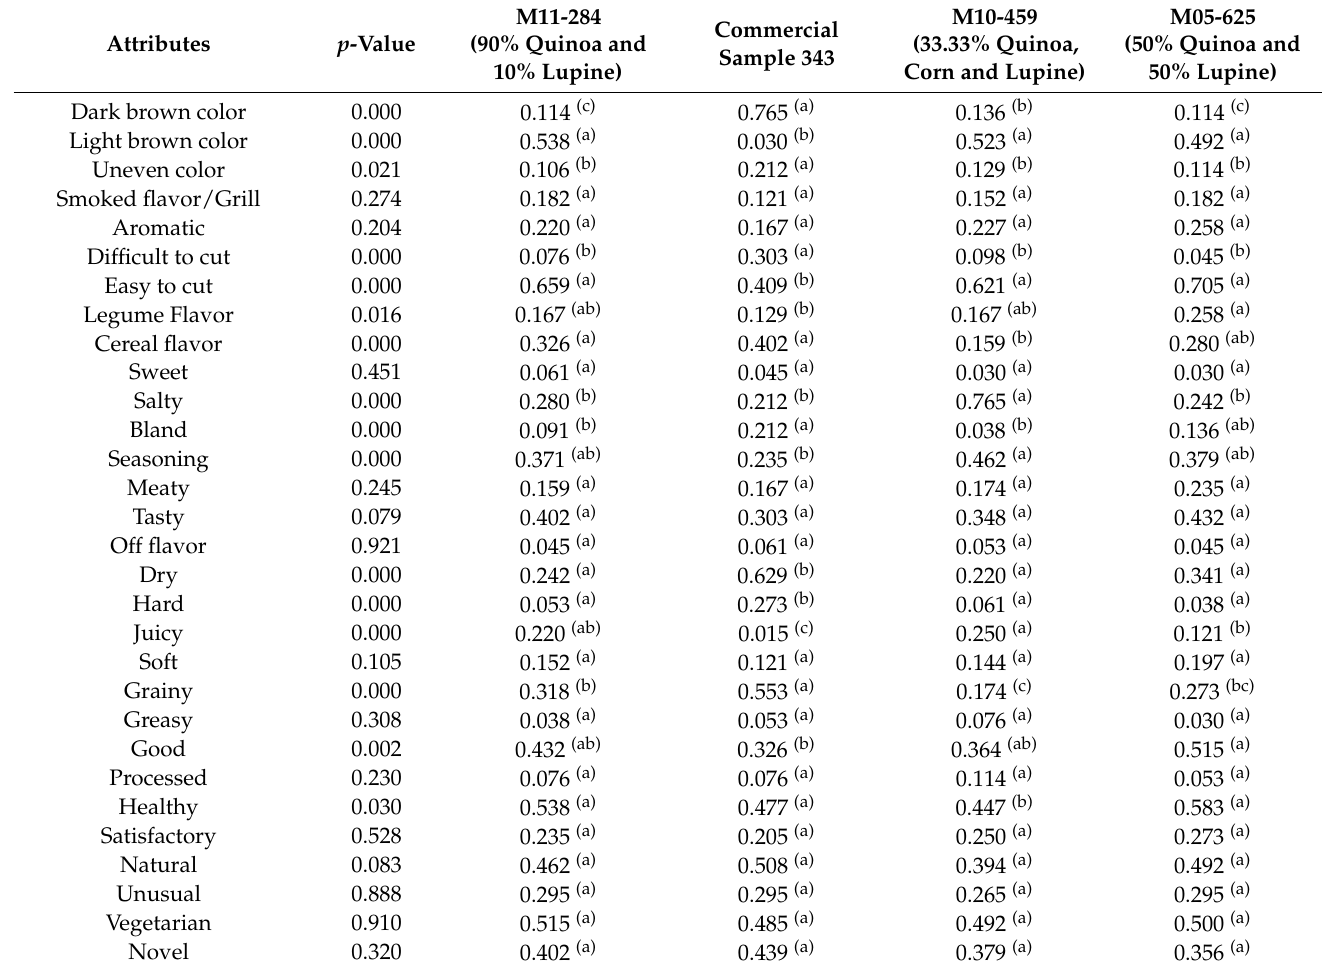
Table 5. Frequency of mention of CATA attributes.